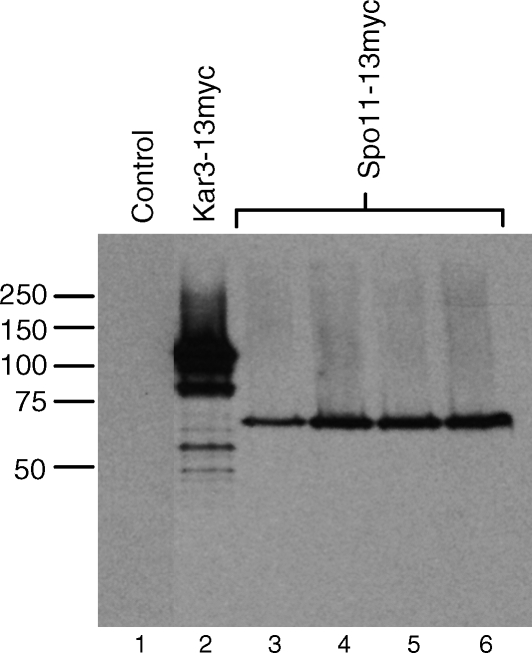
Expression of C. albicans Spo11 Protein in Mitotic CellsThe expression of a Spo11–13 × myc-tagged protein was analyzed by western blotting. Lane 1 shows a control strain lacking the Spo11-13myc fusion construct, while lane 2 shows expression of a Kar3-13myc protein for comparison. Lanes 3–6 show extracts from four independently transformed diploid strains with the Spo11-13myc construct (see Materials and Methods).